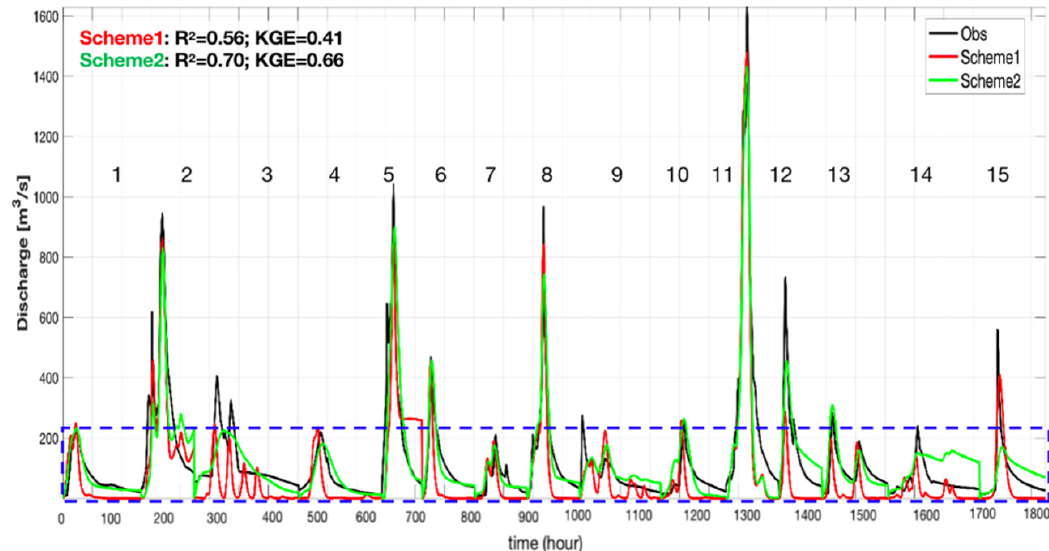
Figure 5. Comparison between observed and simulated streamflow with calibration scheme 1 versus scheme 2. The dashed blue box highlights significant improvements of base-flow simulation from scheme 1 versus scheme 2.